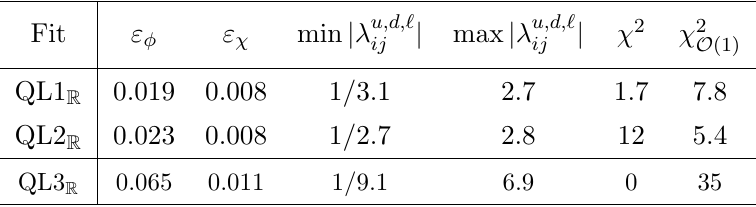
Table 3 . Best (cid:12)ts in the quark and charged lepton sector. Fit